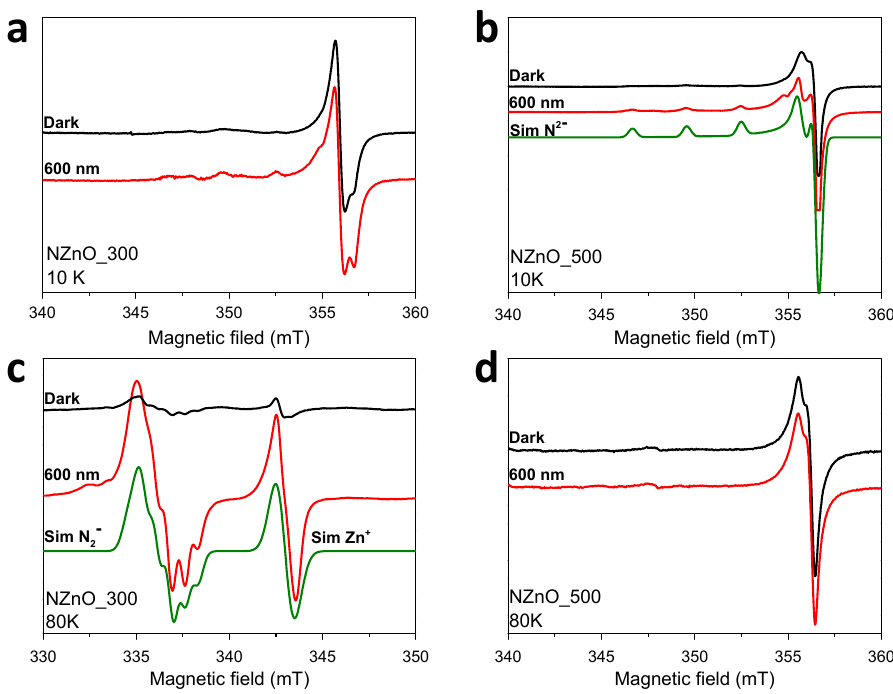
Figure 3. EPR spectra recorded at 10 K and 80 K of NZnO_300 (panel ( a , c ), respectively) and NZnO_500 (panel ( b , d ), respectively). Black line: before laser irradiation. Red line: after irradiation at 600 nm. The green lines in panels ( b , c ) are the simulations for the major components obtained with the parameters reported in the text.